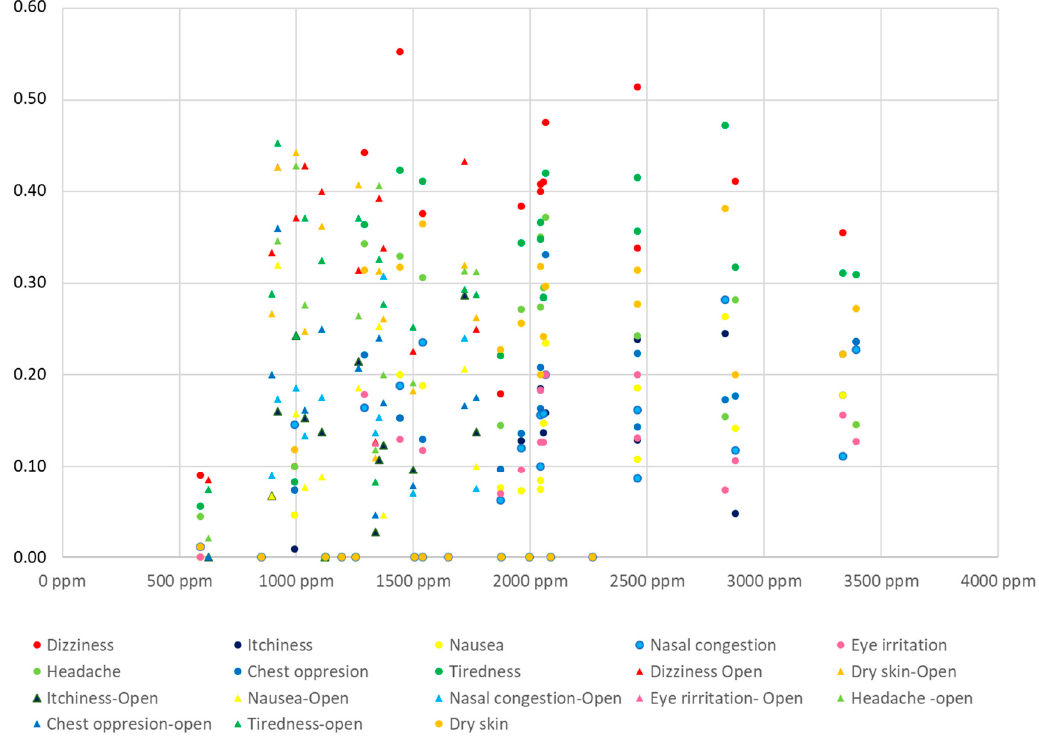
Figure 7. Scatter plot showing CO 2 concentration and student symptomatology.